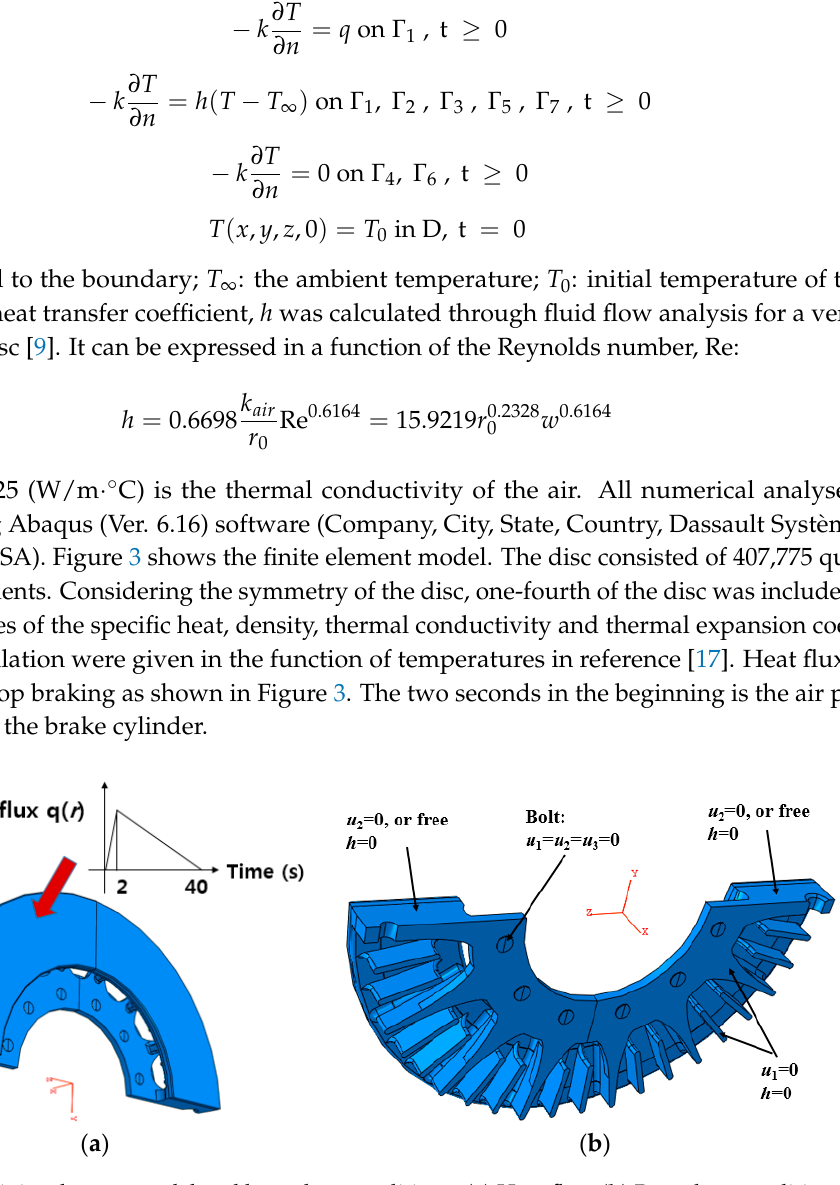
Figure 3. Finite element model and boundary conditions. ( a ) Heat flux; ( b ) Boundary conditions.